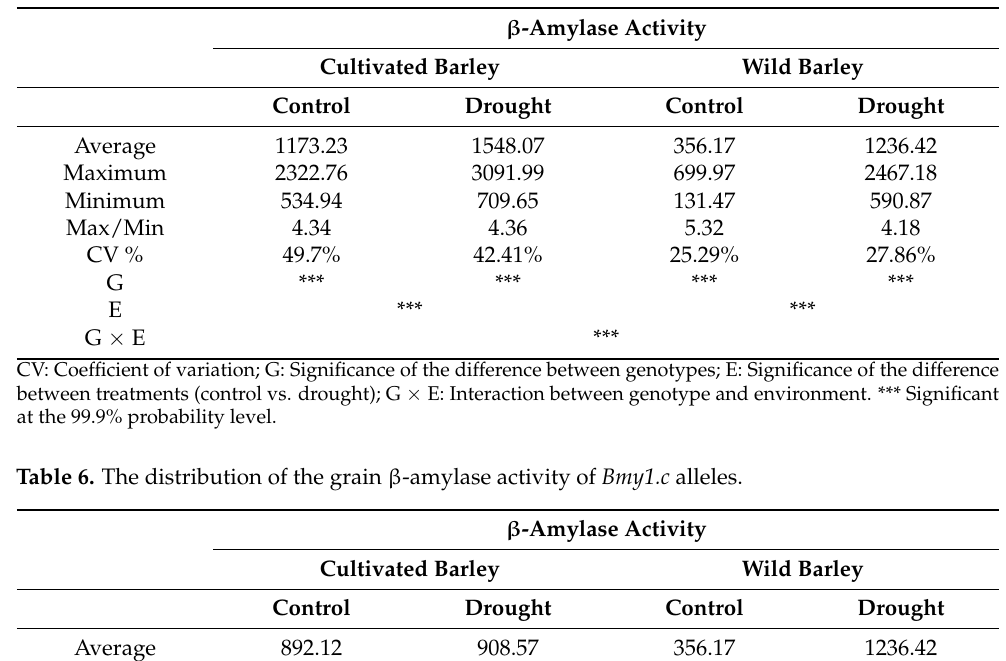
Table 5. The distribution of the grain β -amylase activity of Bmy1.b alleles.